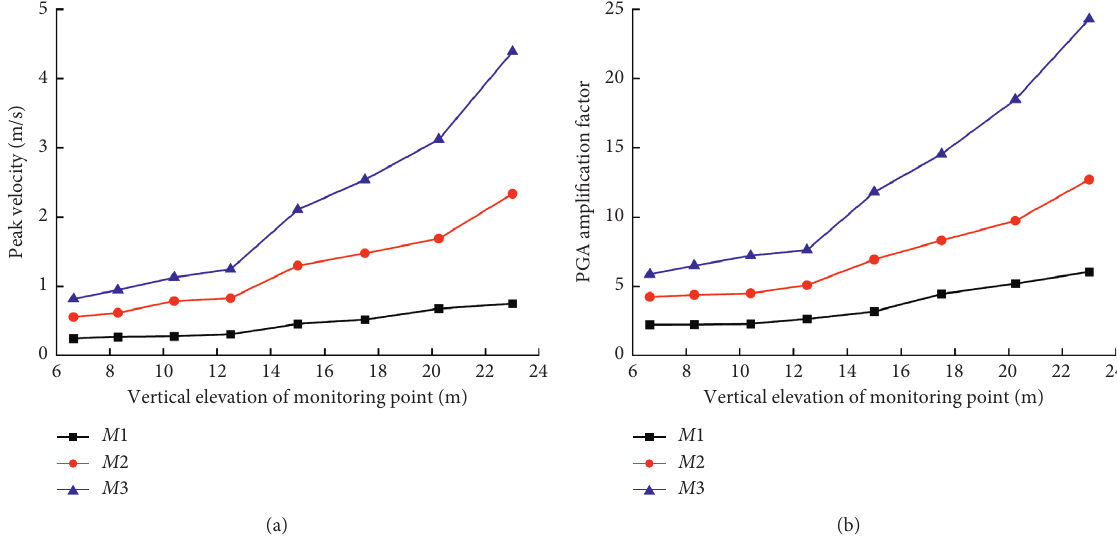
Figure 12: Distribution of peak velocity and PGA amplification coefficient at the monitoring point of B chain joint surface. (a) Peak velocity. (b) PGA amplification